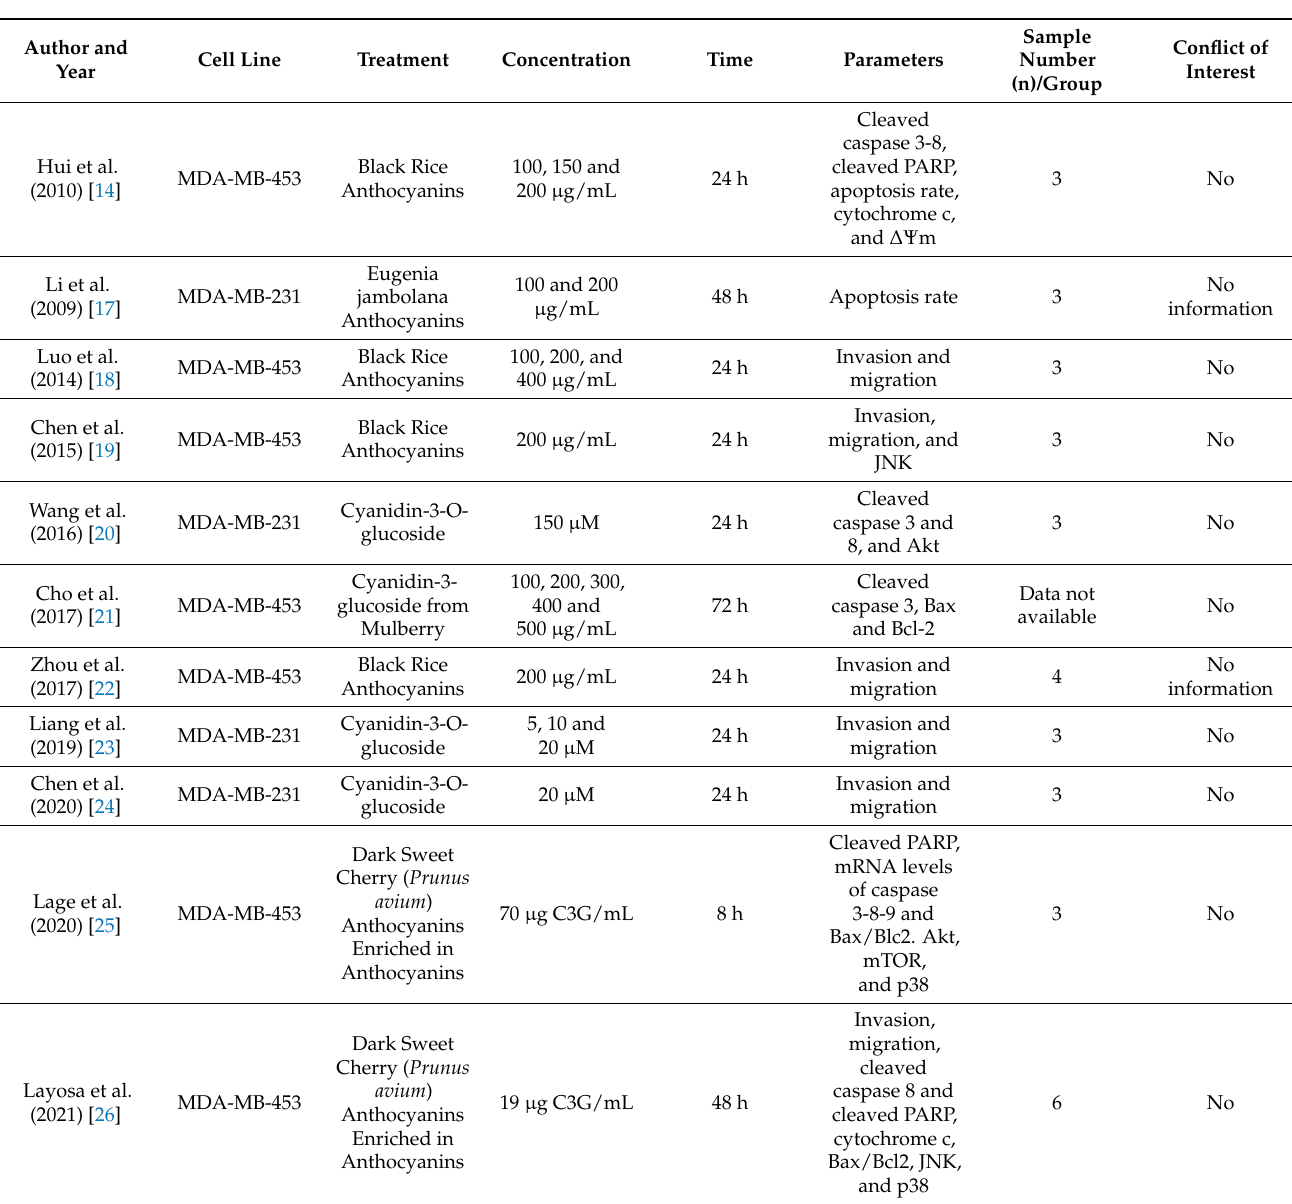
Table 1. Main characteristics of the eleven studies included in the systematic review and ten included in the meta-analysis related to the role of anthocyanins in invasion, migration, modulation of cell signaling pathways, and apoptosis in TNBC cells MDA-MB-231 and HER2+